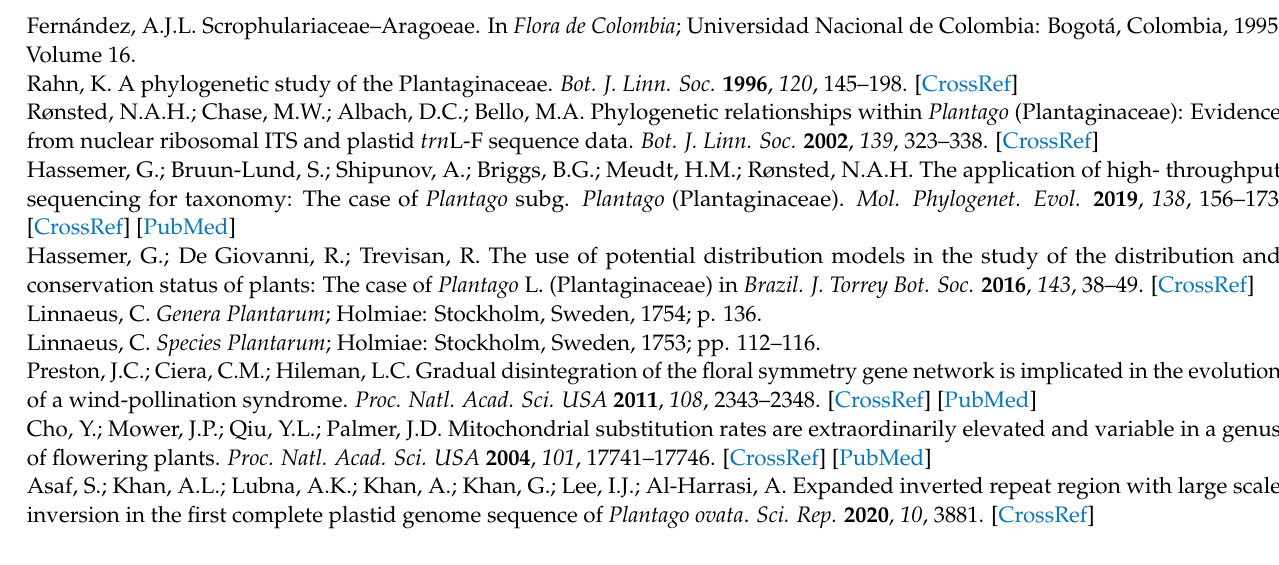
Morphological characters, Table S4: Machine learned placements of the molecularly under-sampled species of Plantago , Table S5: Geographical origin of Plantago species, Figure S1: The single-marker Plantago phylogenetic tree based on COI sequences; this tree is similar to other trees suggesting (together with CADM tests) the absence of